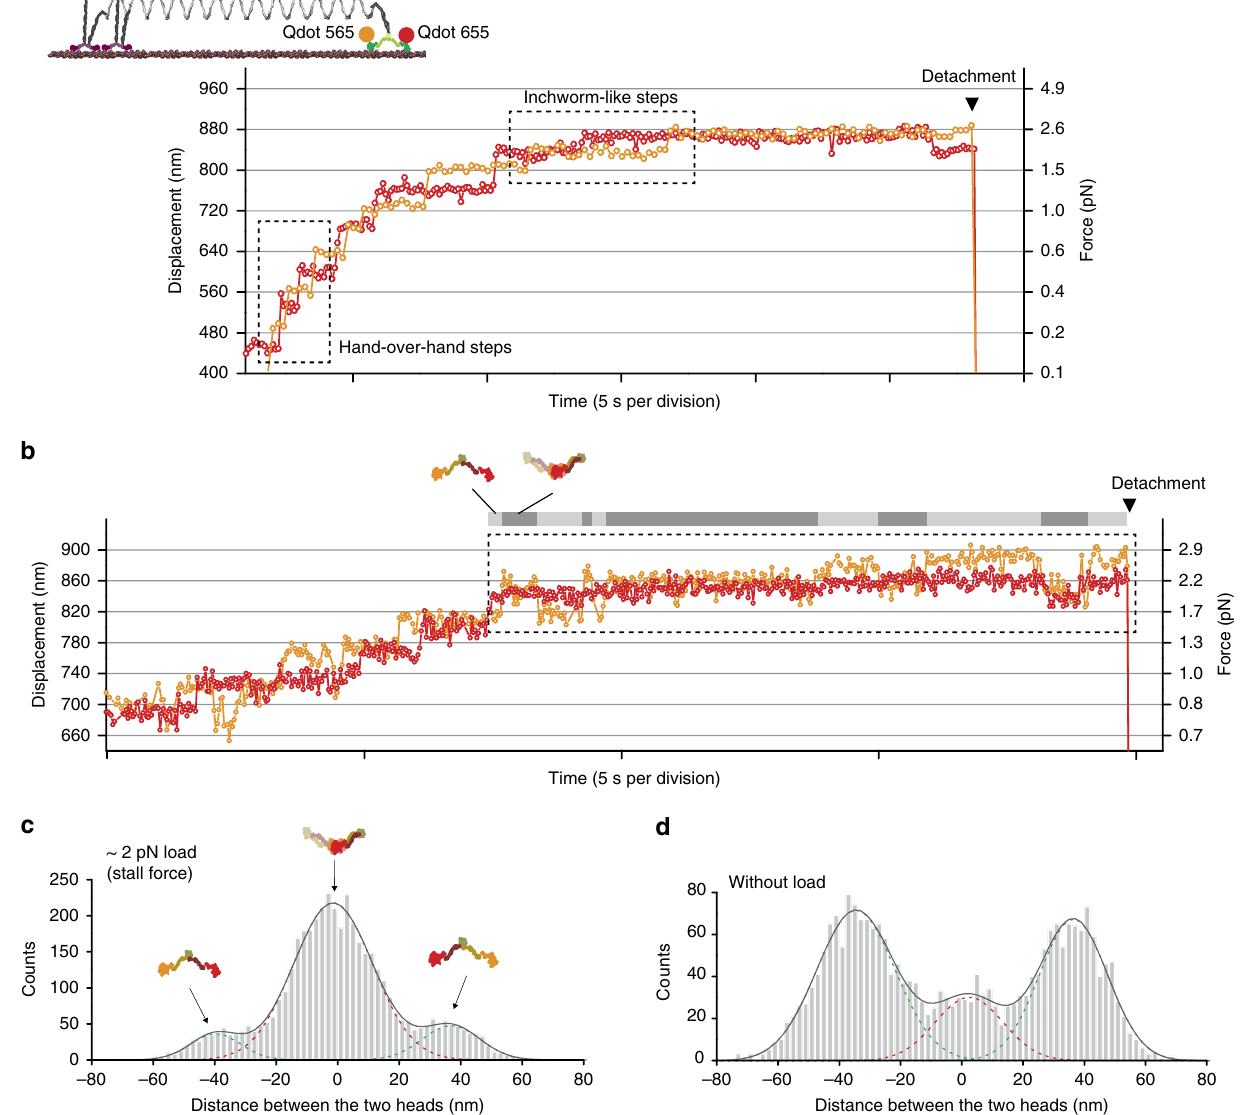
Figure 4 | Simultaneous observation of both heads under load. ( a ) Typical trajectory of QDs attached to both heads showing hand-over-hand steps and inchworm-like steps (dashed-line box). ( b ) Typical trajectory of QDs attached to both heads in the stall state (dashed-lined box). The grey and light grey bars indicate the binding state of myosin VI onto actin (grey, adjacent binding states; light grey, distant binding states). Recording rate, 10Hz for ( a ) and 30Hz for ( b ), respectively. Nucleotide condition, 2mM ATP þ 100 m M ADP. The arrowhead shows detachment from actin. ( c , d ) Distance between heads at stalled state ( c ) and at unloaded state ( d ). The distribution fit to three Gaussian functions (solid and broken lines) with peaks at 37 ± 9.3nm, (cid:2) 1.5 ± 13nm and (cid:2) 39 ± 8nm for c , and 36 ± 11nm, 2.4 ± 11nm and (cid:2) 34 ± 12nm for d . The peak around 0nm is interpreted as a convolution of positive and negative distances for the adjacent binding state. Error indicates